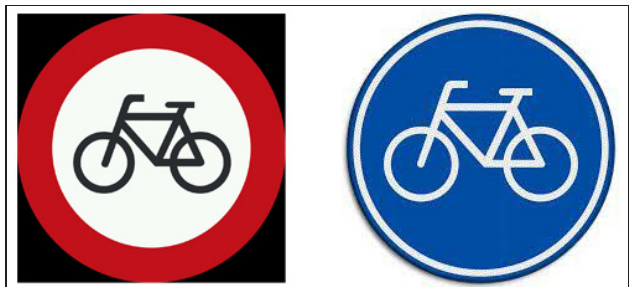
Figure 2: Micromanagement via